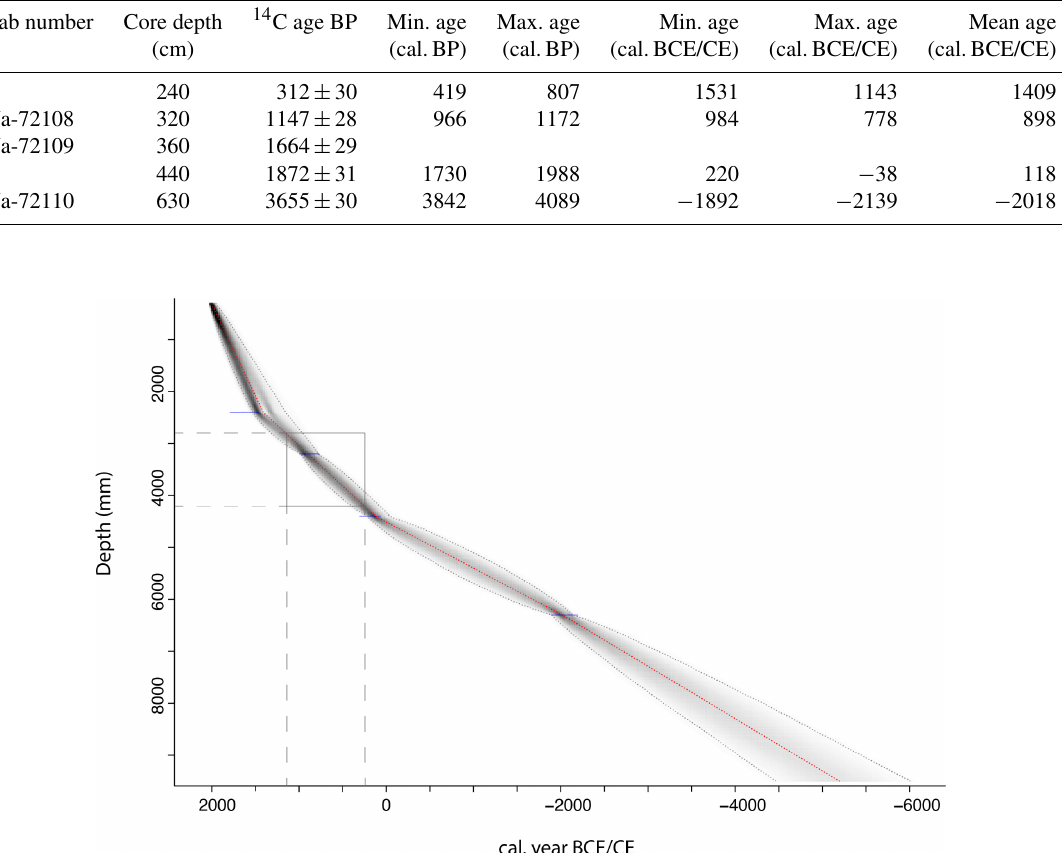
Table A3. Radiocarbon ages for Åsheim peat sequence.